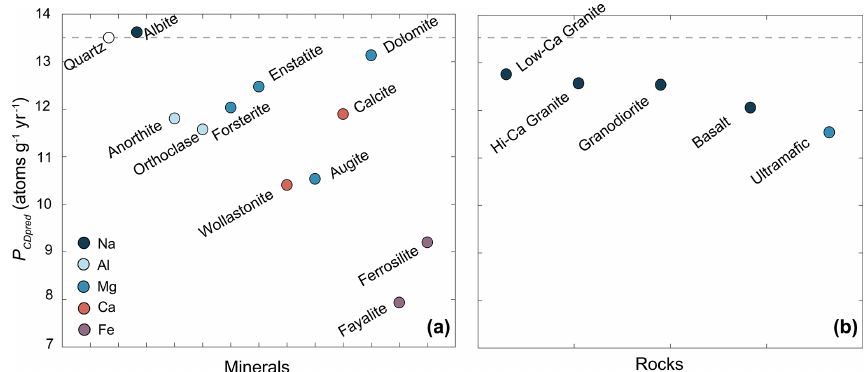
Figure 2. Predicted theoretical SLHL production of in situ 14 C ( P CDpred ) in minerals (a) and rocks (b) relative to that in pure quartz (dashed gray line). The color of each symbol reflects the element that contributes the highest proportion of production after oxygen and silica.